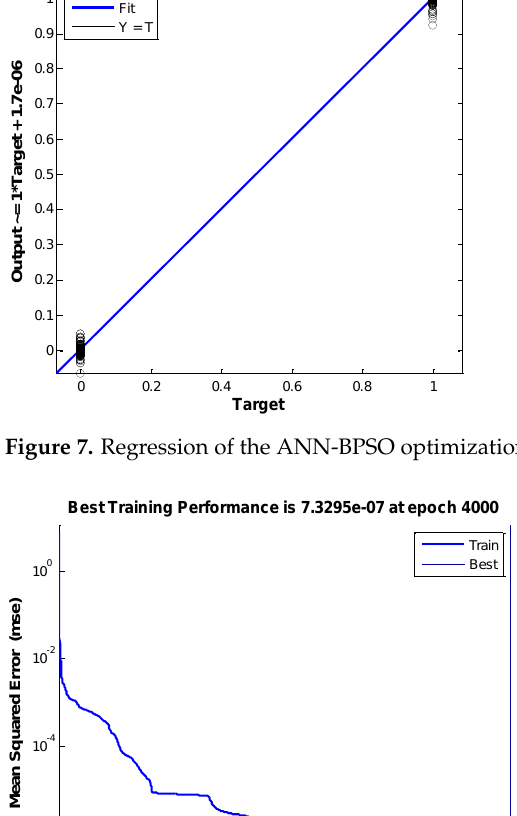
Figure 7. Regression of the ANN-BPSO optimization.